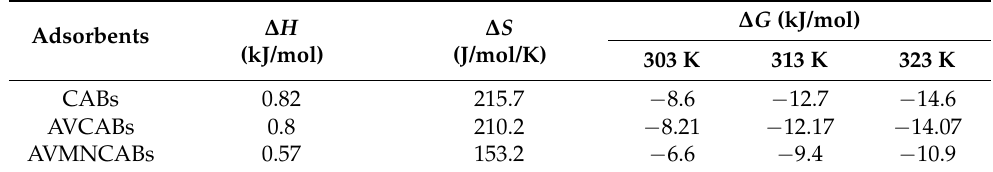
Table 5. Adsorption capacities of different adsorbents—comparison with literature.